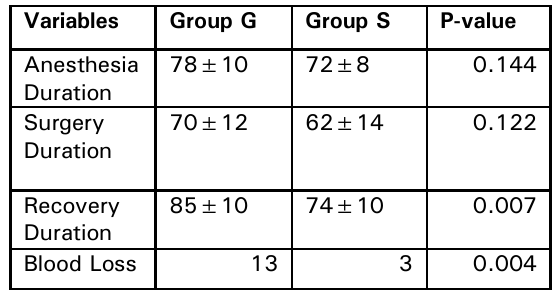
Table 4: Comparison of Post-Operative Outcomes Table 4: In terms of Post operative